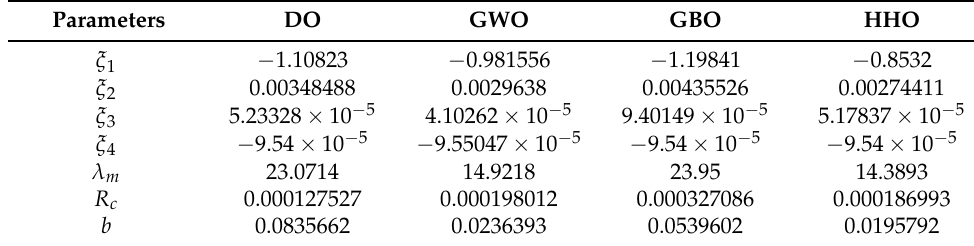
Table 4. Optimal parameters of NedStack